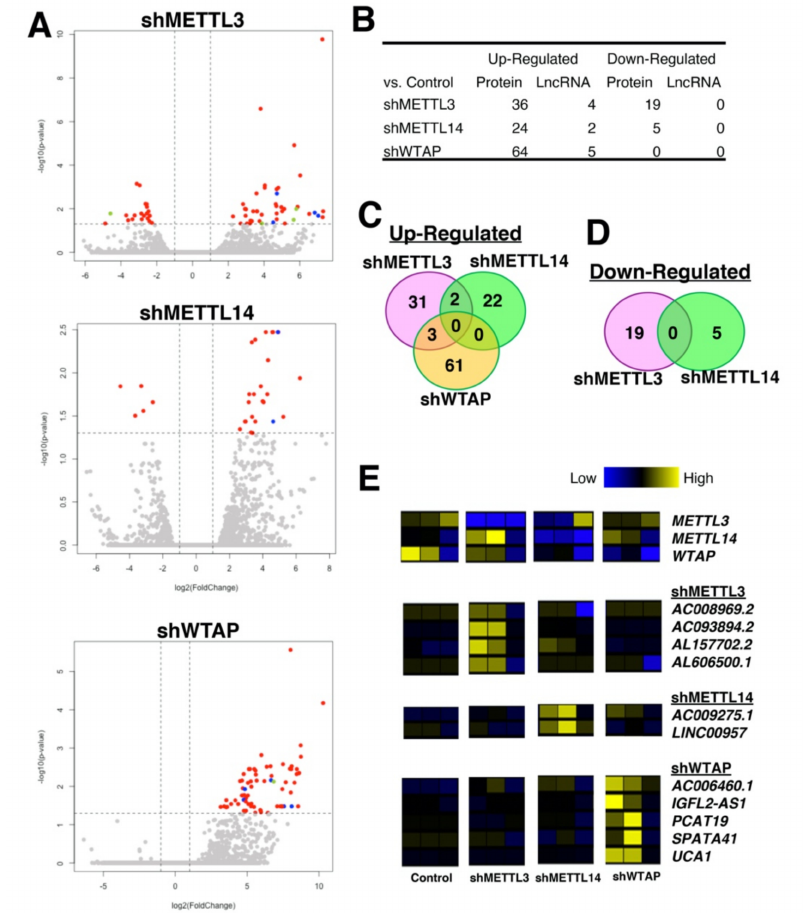
Figure 2. RNA-seq data of silencing of m 6 A writers in HepG2 cells. ( A ) volcano plots comparing silencing of METTL3 , METTL14 , or WTAP to the control sample group. With the threshold values of 2-fold and FDR-adjusted p < 0.05, protein-coding genes are colored in red, lncRNA genes in blue, and other genes (e.g., pseudogenes) in yellow-green. ( B ) the table indicates the number of differentially expressed genes for each category. ( C , D ) Venn diagrams for shared protein-coding genes that are ( C ) up- and ( D ) down-regulated in each condition. ( E ) heatmaps of target m 6 A reader genes followed by up-regulated lncRNA genes in each